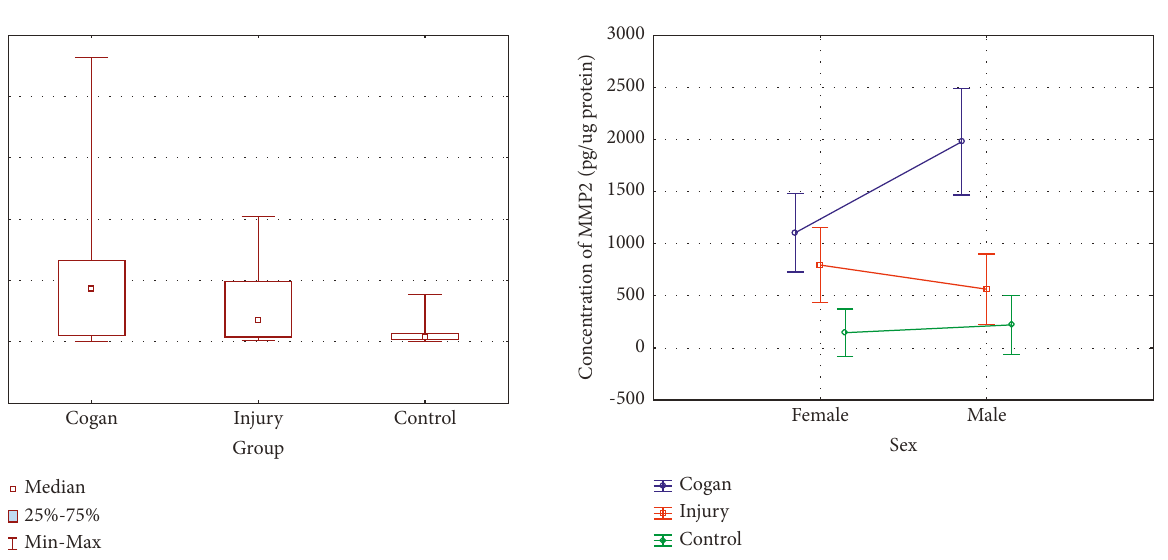
Figure 4: Assessment of the influence of sex and group on the values of MMP-2 concentration.